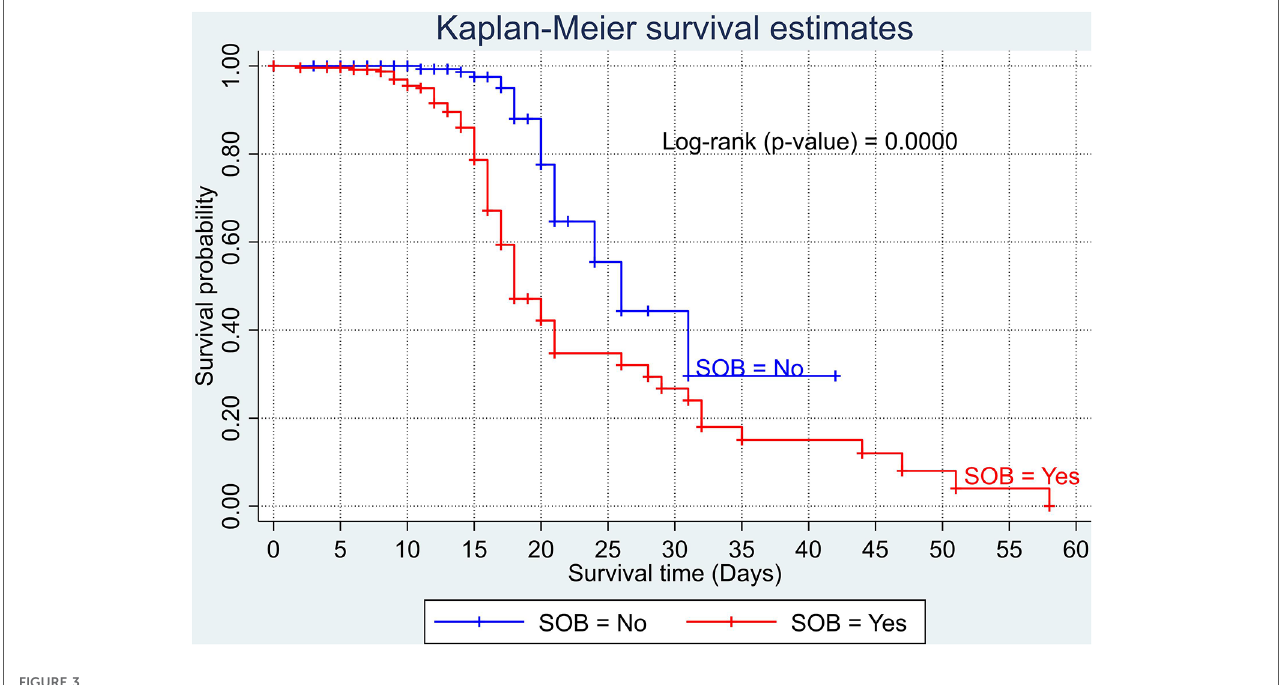
FIGURE 3 Kaplan – Meier survival curve based on the presence of shortness of breathing at admission among adult COVID-19 patients.